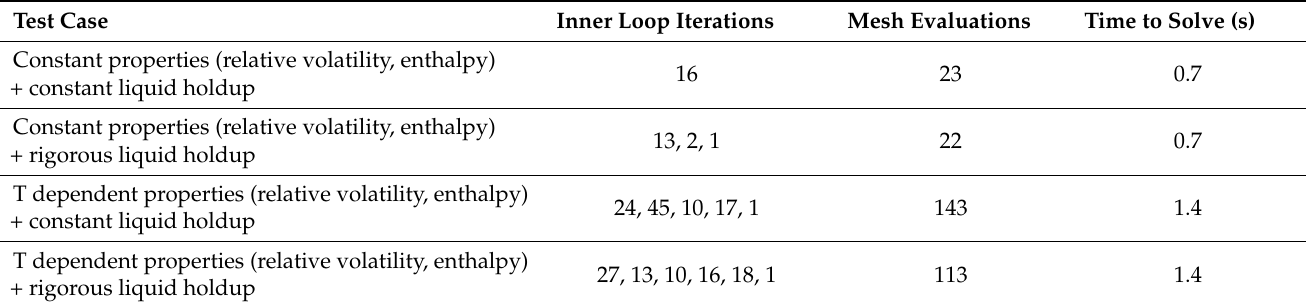
Table 2. Convergence characteristics of several test cases. All cases are for Luyben’s column with real component properties for cases 3 and 4. T-dependent properties are taken as ideal component properties of the methyl acetate system (A = methanol, B = acetic acid, C = methyl acetate, D = water), Antoine and enthalpy (C p , ∆ f H ) parameters and correlation coefficients were retrieved from the Aspen Plus databank. The number of values given for the iterations represents the number of outer loop